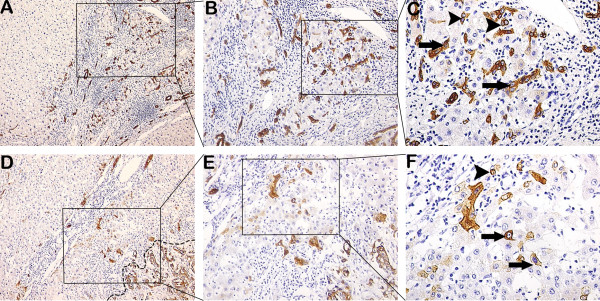
Immunostaining of DR, histopathology of HPCs and intermediate hepatocytes in fibrotic tissue or peritumoral and tumoral tissues. (A, B, C) DR emanated from the portal zone and expanded into the parenchyma of proliferative nodules, HPCs (arrowheads) and intermediate hepatocytes (arrows) can be seen in the nodules. (D, E, F) DR and CK-19 positive tumor (in dashed line) that had no capsule were shown. HPC (arrowhead) was close to DR, intermediate hepatocytes (arrows) were between DR and neoplastic nodule. (A and D 100×; B and E 200×; C and F 400×).